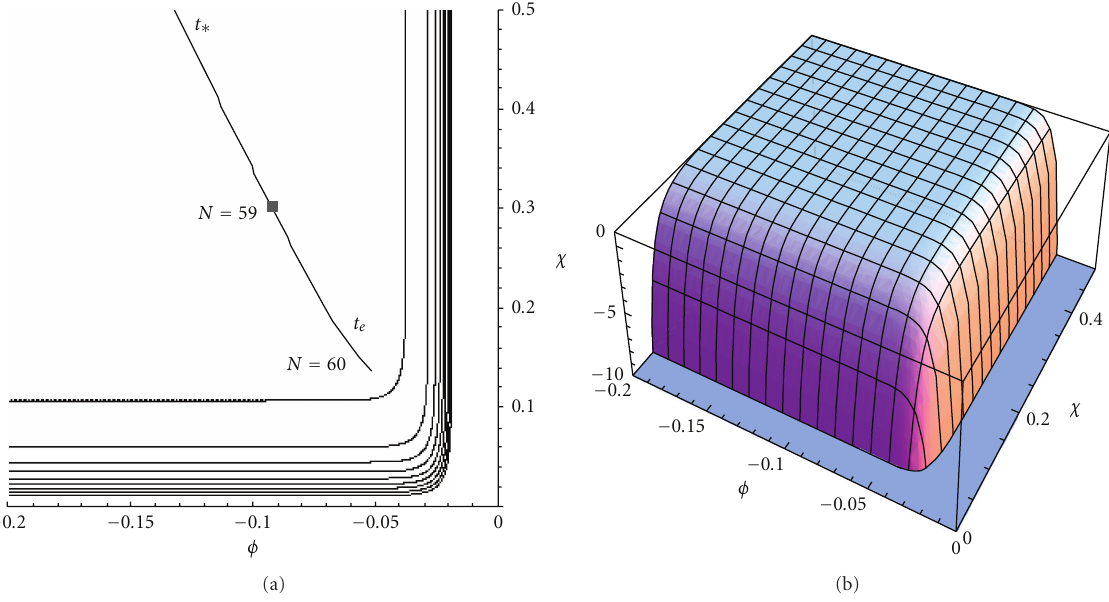
Figure 2: (a) shows the trajectory considered for the parameters given after (66) superimposed on a contour plot of the potential. The trajectory is shown from the time of horizon crossing at t ∗ and runs until the end of inflation at N = 60. The square on the trajectory, labelled with N = 59, indicates a point along the trajectory one e -folding before inflation ends as φ and χ roll towards zero. This shows that the fields roll much more quickly during the final stage of inflation, and the trajectory curves near the end. (b) shows the potential for the same parameter values. Notice that inflation ends on the plateau long before the potential becomes